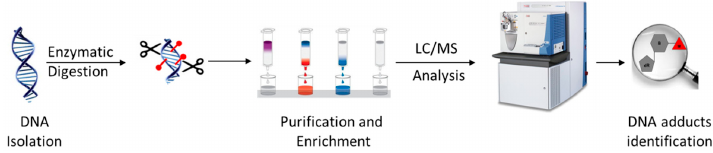
Figure 1. Summary of a typical sample preparation and analysis workflow for DNA adductomics analysis.